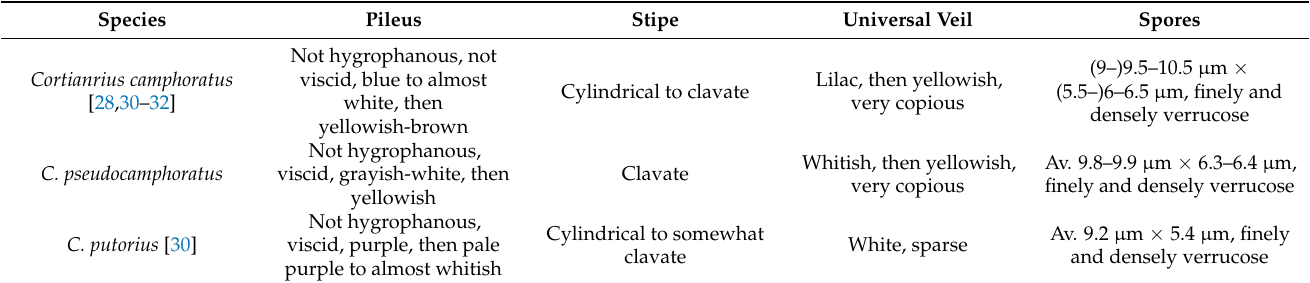
Table 3. Morphological comparisons of the new species and their similar species in sect. Camphorati